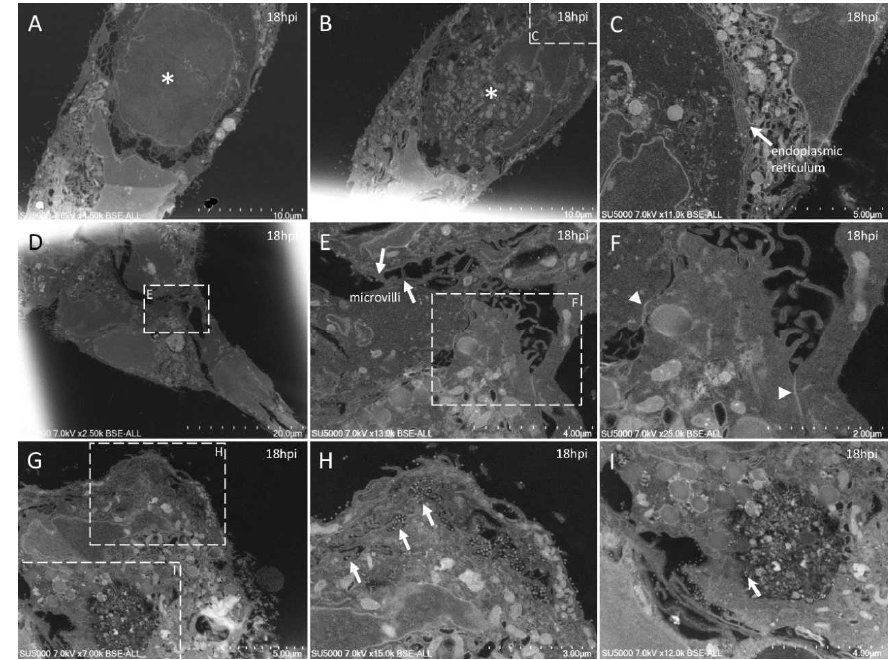
Figure 5. Ultra-thin sections of SARS-CoV-2-infected Vero E6 cells: 18 hpi. ( A , B ): Two serial sections of the same cell, with cuts at the level of its nucleus (*) at different heights along its depth. In ( C ), the nuclear membrane/endoplasmic reticulum presents a stacked organization (arrow). ( D – F ): Adjacent cells contacting each other through microvilli ( E ) or electron-dense regions resembling tight junctions ( F ; arrowheads). ( G – I ): SARS-CoV-2 particles (arrows) located inside a canalicular tubulo-vesicular system ( H ) as well as in a virus-morphogenesis vesicle (VMV; I ) of the same